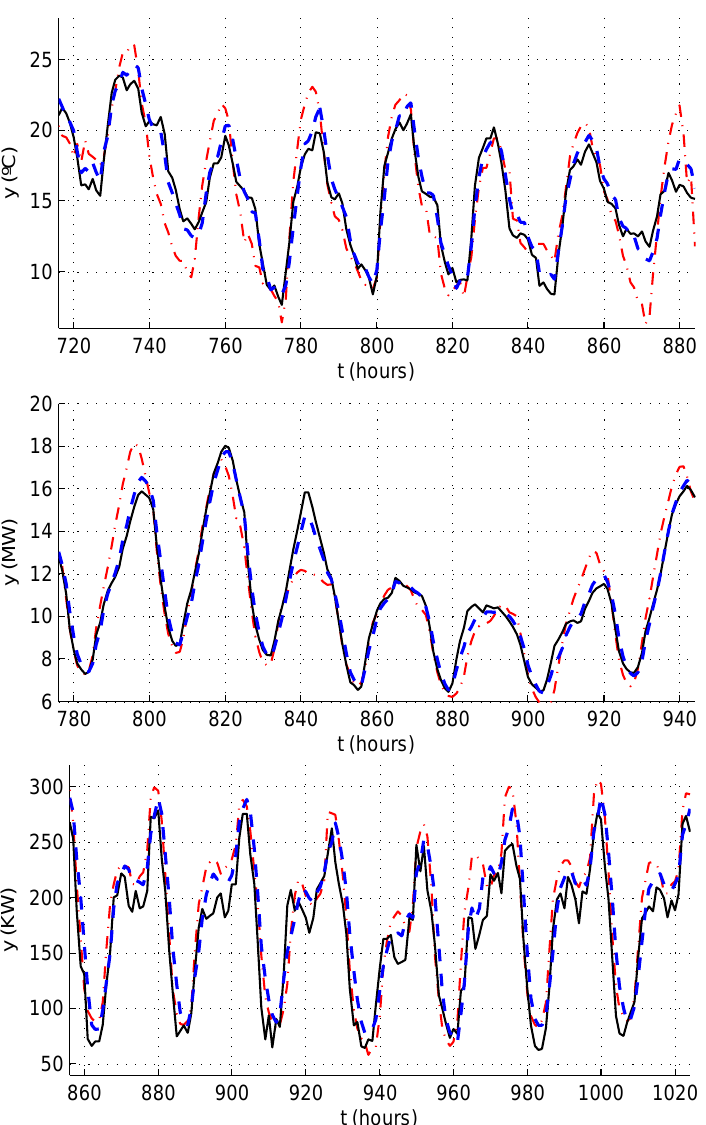
Figure 2. Forecasting results in 7 days of new data for the three datasets ( Top ) T1 ( Middle ) E1 ( Bottom ) E2. In all cases the predicted variable is presented with a dash-dotted red line, the forecast given by the MLP is the black solid line and the LLHGM forecast is shown as a blue dashed